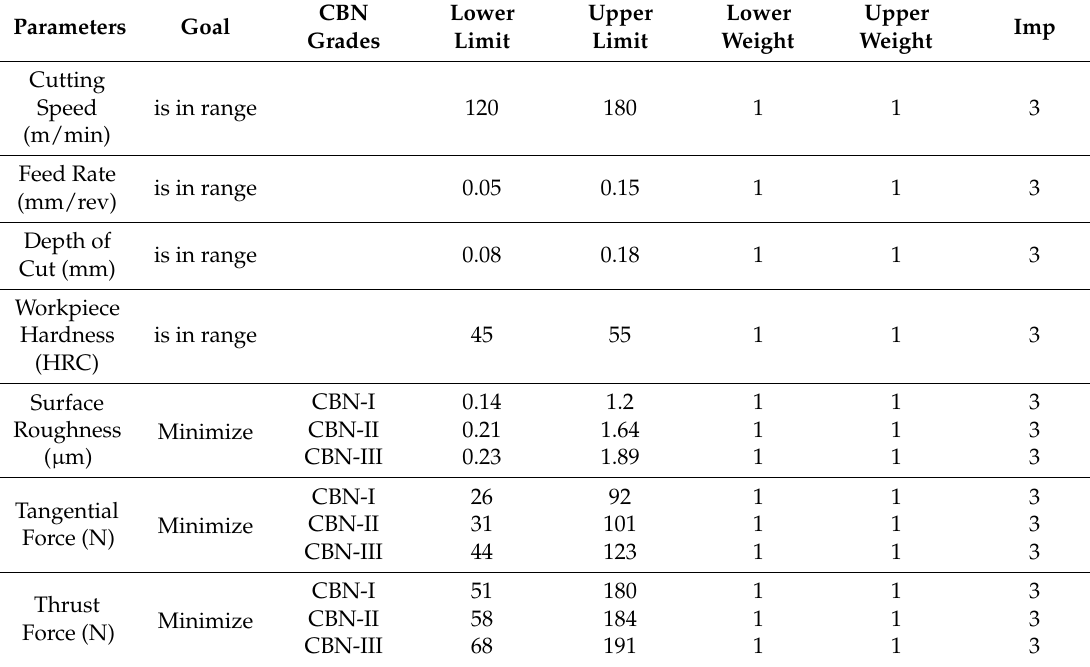
Table 14. Range of parameters with weight-age and importance for different